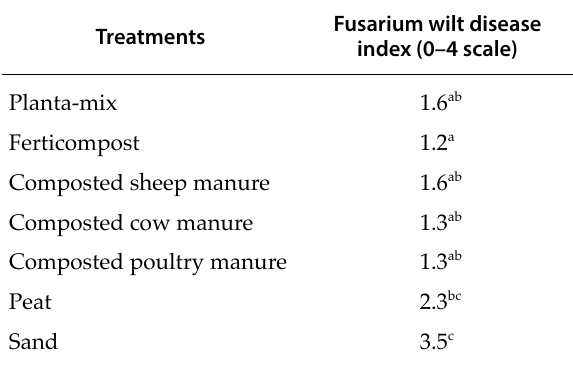
Table 2. Mean Fusarium wilt severity indices on tomato plants grown for 21 d in five different compost-peat mixes (20:80), peat or sand, and 10 d after inoculation with Fusa- rium oxysporum f. sp. lycopersici